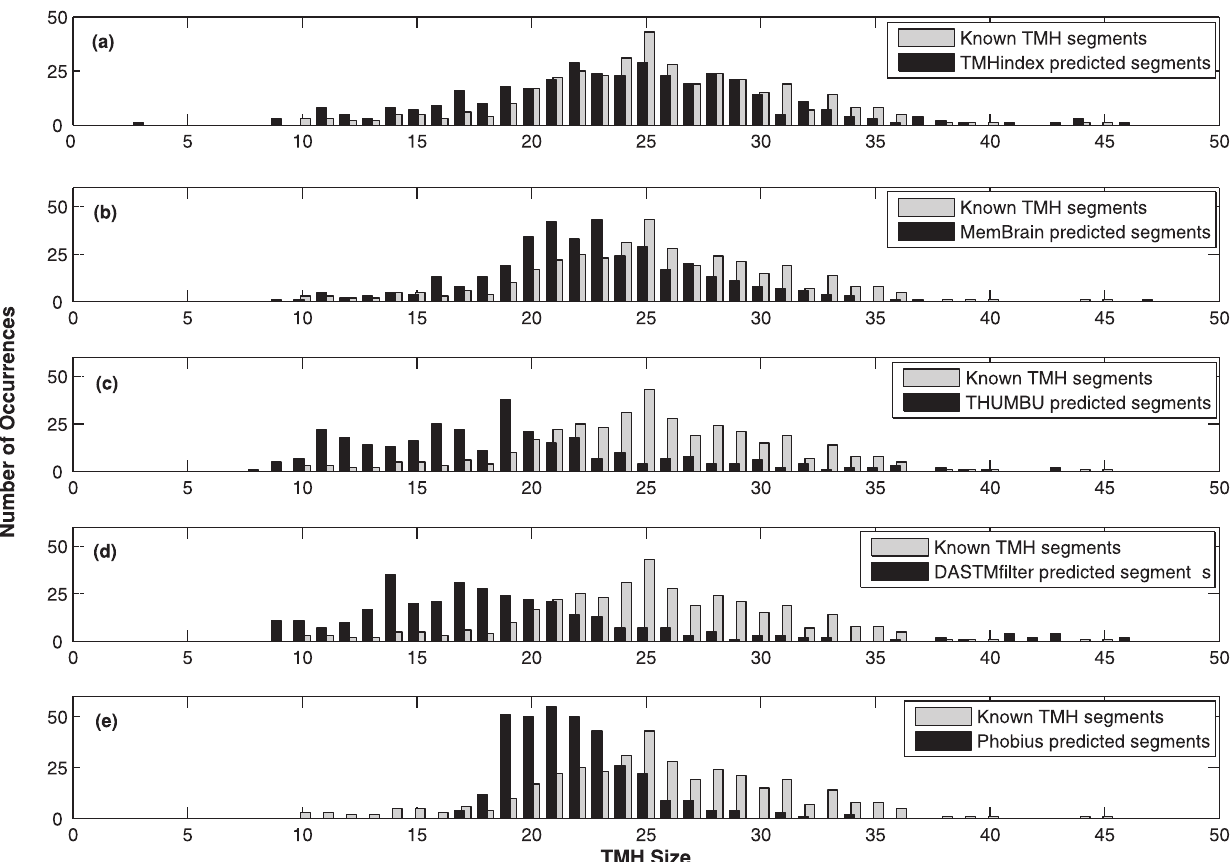
Figure 8. Length distribution of the 378 known TMHs in the testing dataset compared to predicted TMHs using (a) TMHindex, (b) MemBrain, (C) THUMBU, (d) DAS-TMfilter and (e)Phobius methods.